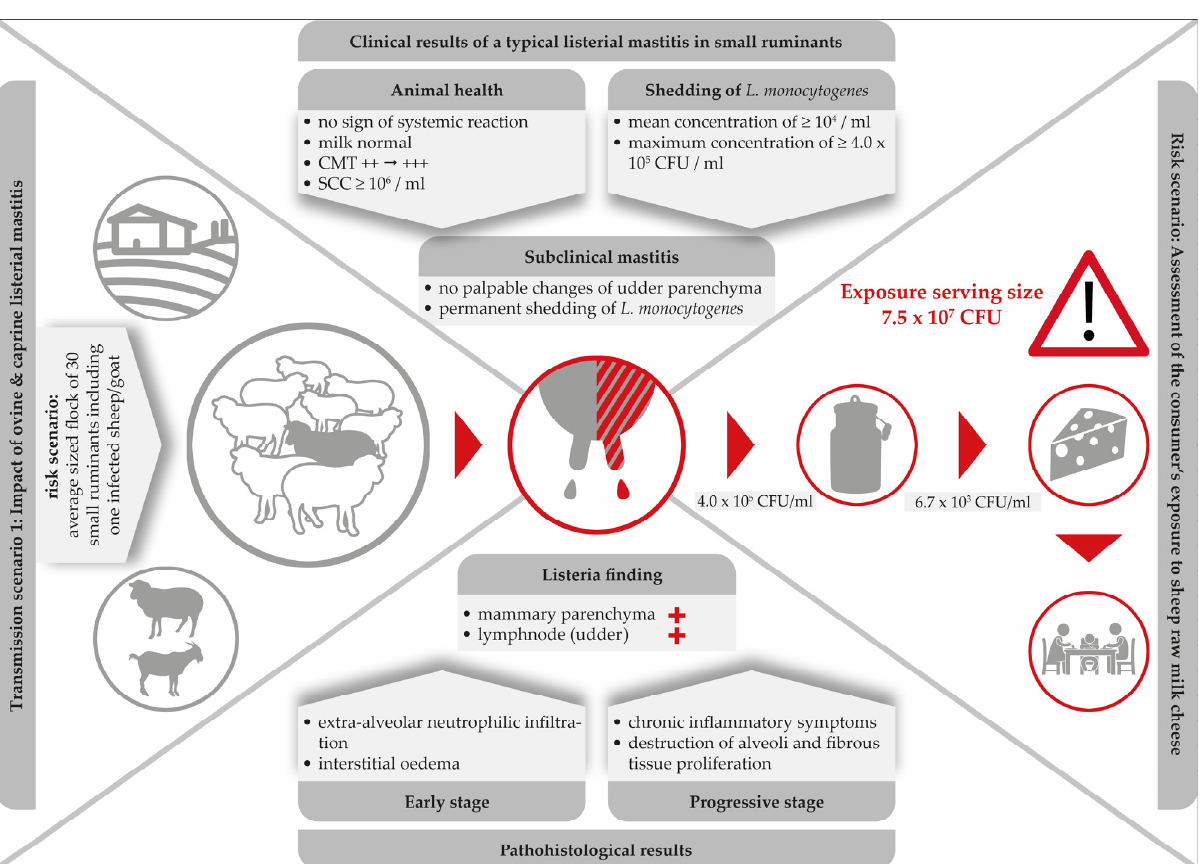
Figure 2. Clinical and histopathological findings in a typical listerial mastitis in small ruminants and consequences for the safety of cheese produced on-farm.